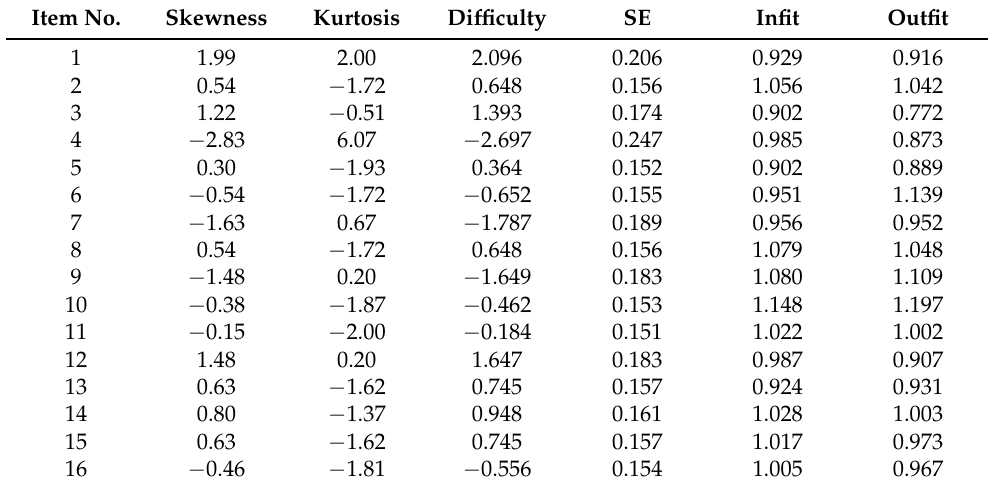
Table 3. Overview of the relevant parameters for a dichotomous Rasch Model; “SE” stands for the standard error of item difficulty. See text for